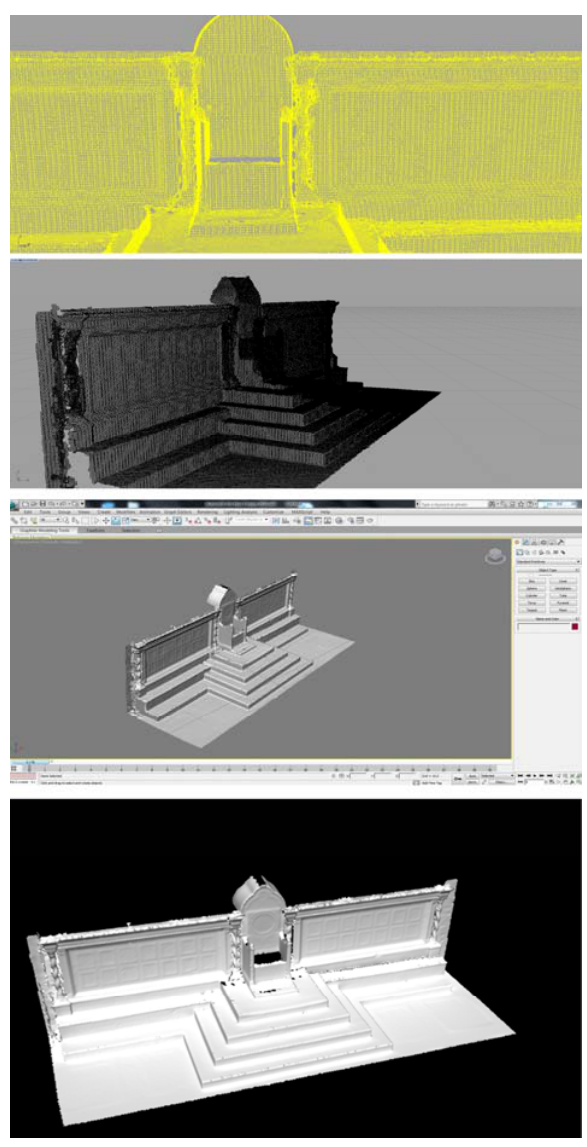
Figure 7. The images of the 3D model carried out automatically by the software. It’s visible the effect of smoothing The experiments carried out, in the case of clouds acquired with image-based method took into consideration systems both calibrated (Menci) and not calibrated (Autodesk 123D Catch).